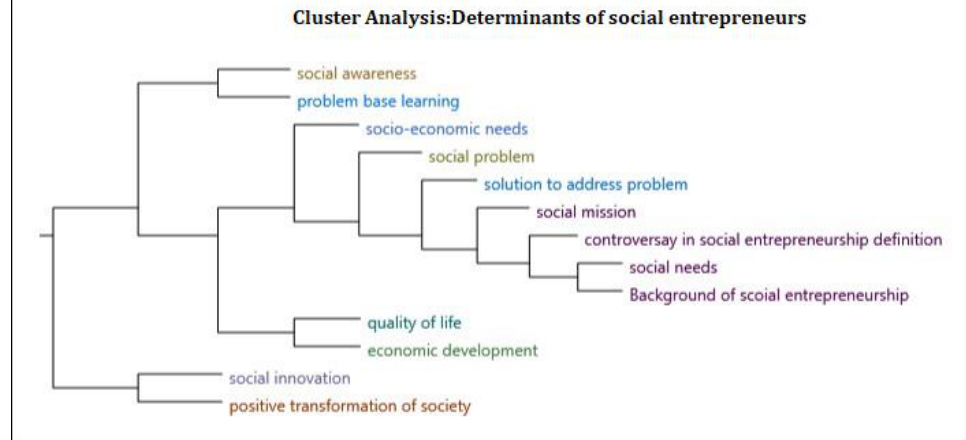
Figure 4.1. Cluster Analysis extracted from Nvivo based on Coding